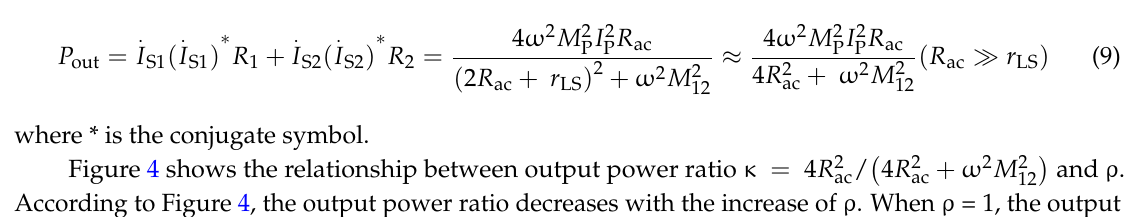
Figure 4. The output power ratio curve.